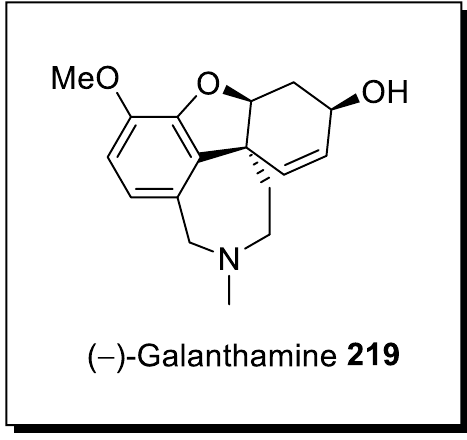
Figure 3. Structure of (−) -galanthamine 219